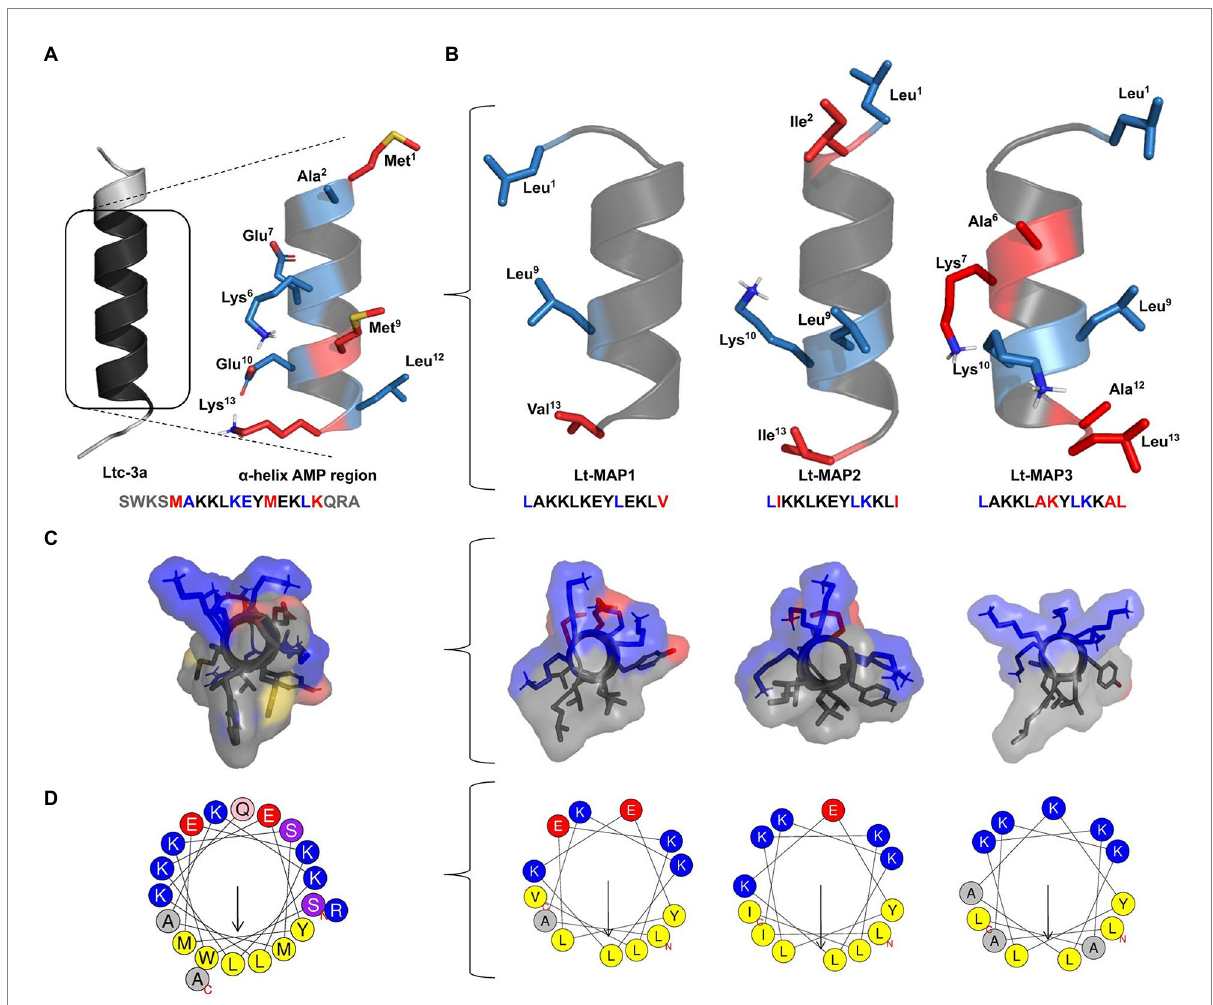
FIGURE 1 Rational design of latarcin (Ltc-3a) analog peptides. Initially, (A) reduction in the length of the primary sequence of the toxin; (B) Analogs peptides,Lt-MAP1, Lt-MAP2, and Lt-MAP3, with the three-dimensional structures and primary sequence of the AMP region represented by red: non-repeated amino acid residues in all analogs and blue: repeated amino acid residues shared between both analogs. (C) Front view for electrostatic surface of the analog’s peptides, and (D) Helix diagram comparing adjusted amphipathic and hydrophobic